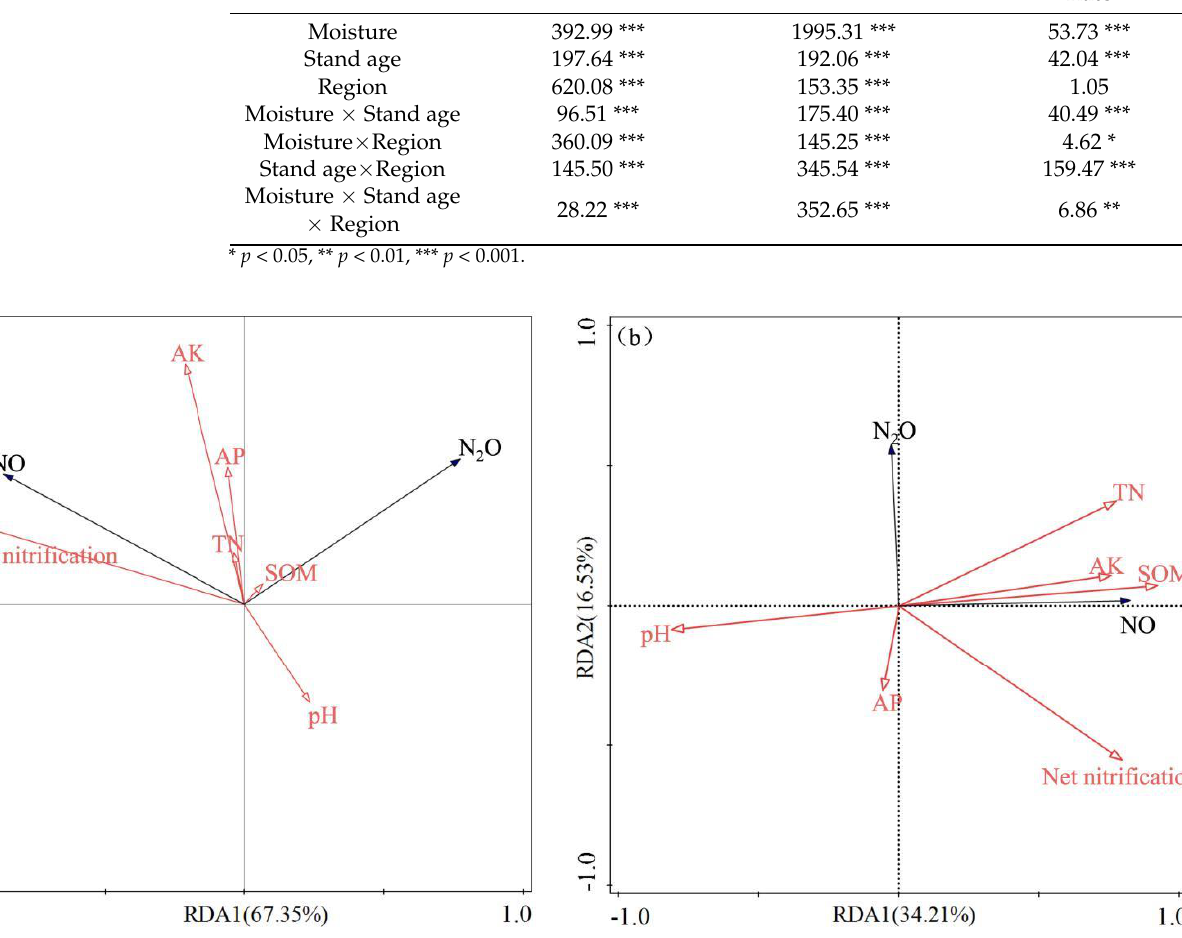
Table 3. Results of multi-factor ANOVA with the factors of soil moisture, stand age, and region. Analysis of Variance